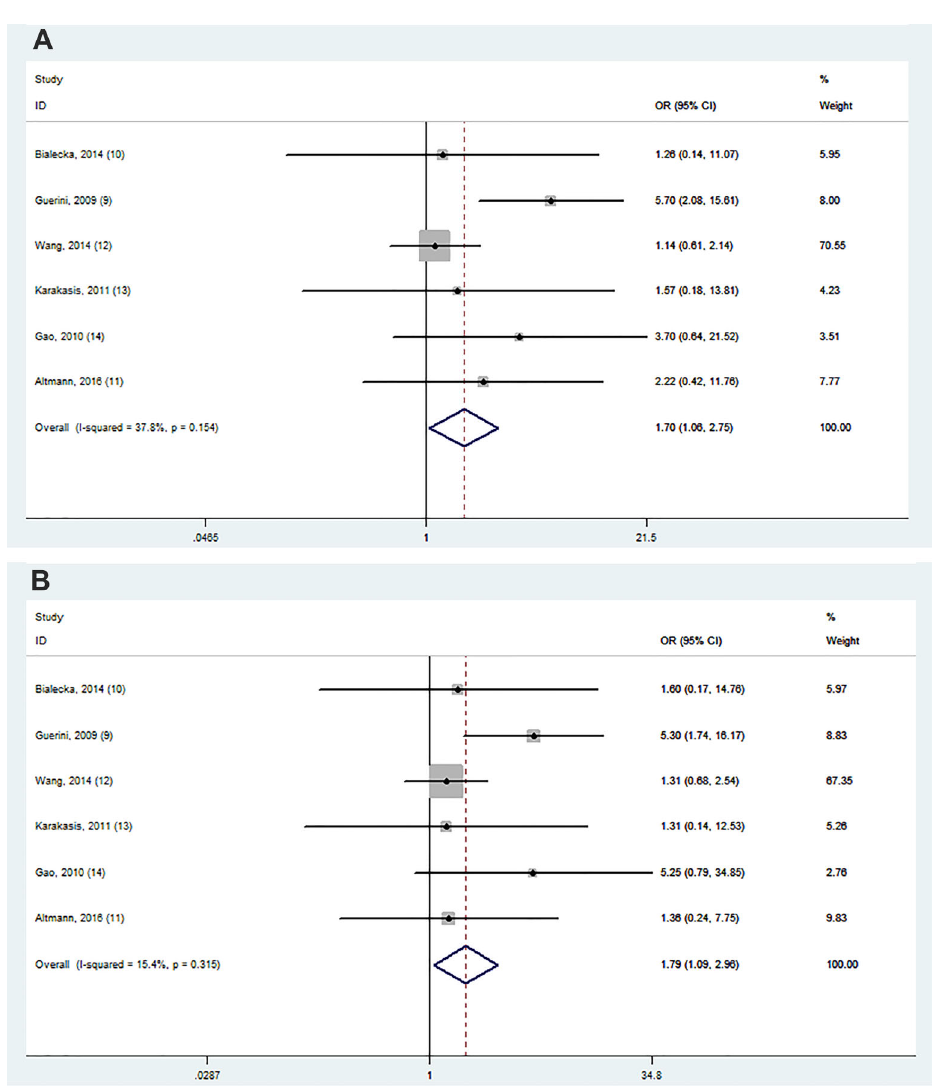
Figure 2. Forest plot showing odds ratio for the associations between rs6265 and cognitive impairment in PD ( A : AA vs GA + GG; B : AA vs